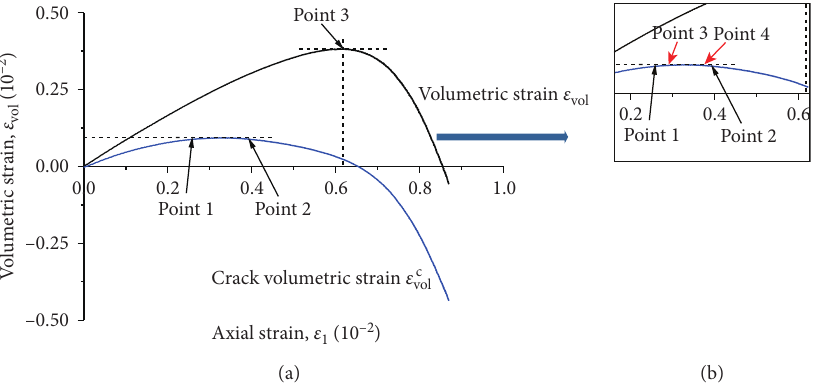
Figure 2: Typical damage threshold confirming curves by the Lajtai method: (a) the damage point of rocks; (b) the subjective error analysis